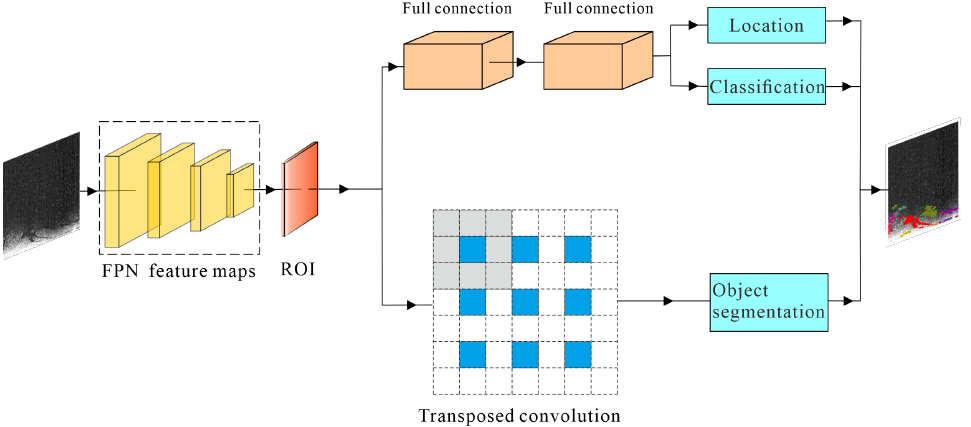
Figure 2. General architecture of the oil spill detection and segmentation model.